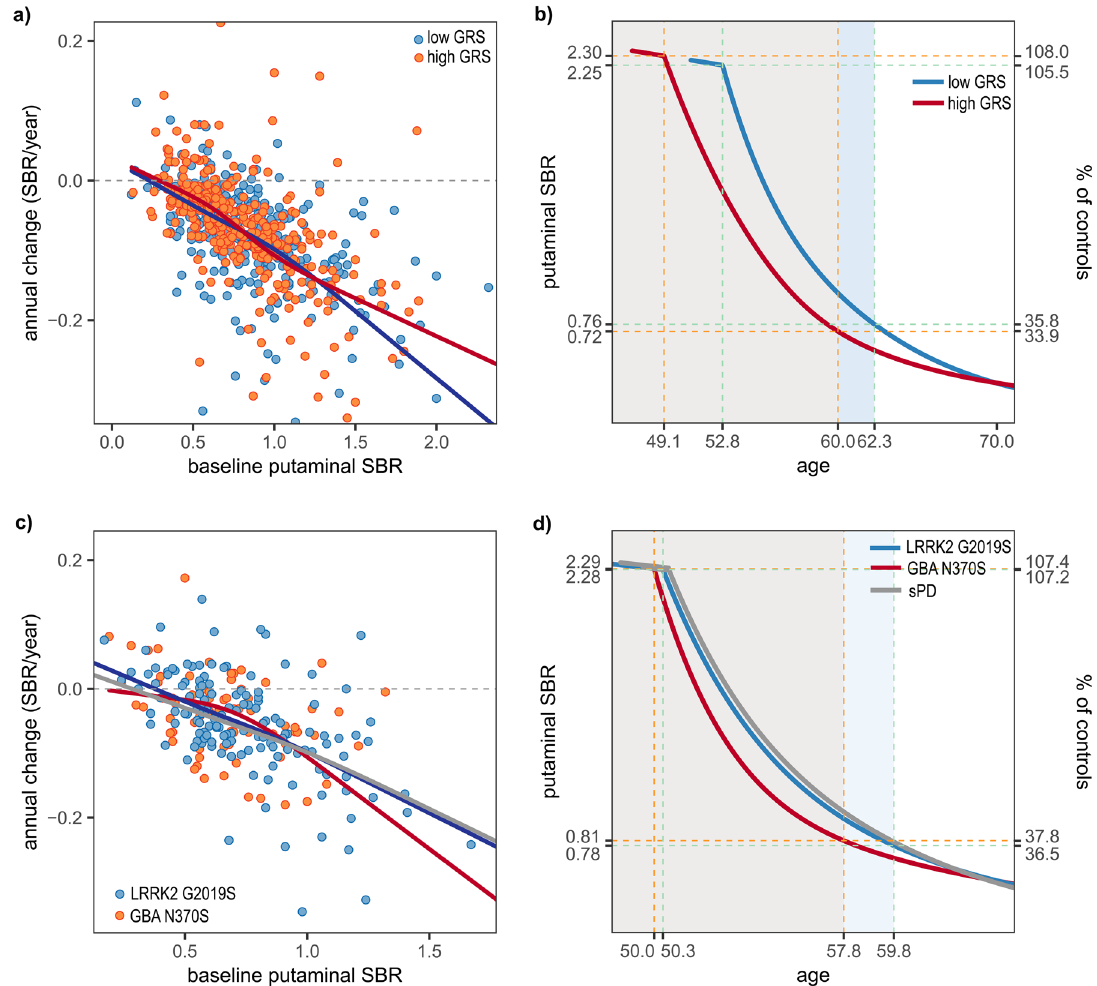
Fig. 4 Comparison of annual change rates against baseline SBRs and DAT trajectories according to genetic aspect. Outliers beyond the fi rst or third quartile ± 3 × interquartile range are not shown in panel ( a ) (5 putamen, sPD group of PPMI cohort). All outliers were included in the calculation of temporal trajectories. The sPD patients with high GRS values have a smaller annual change rate ( a ) and longer premotor phase in the estimated trajectory than those with low GRS ( b ). Compared to LRRK2 PD patients, GBA PD participants exhibit a lower annual change rate within the range over 0.9 of the baseline DAT SBR ( c ), and a rapid decline in estimated DAT SBRs during premotor phase ( d